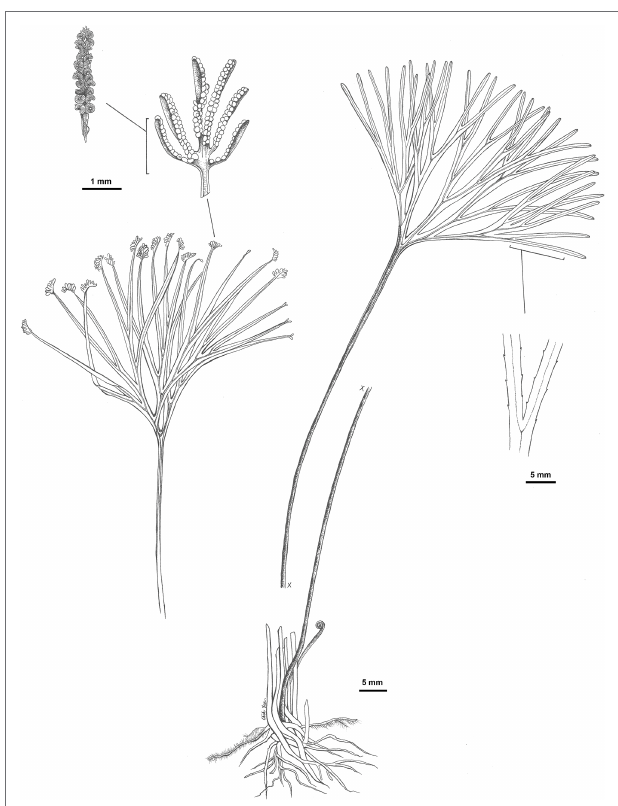
FIGURE 5 | Illustration of Schizaea medusa L.-Y. Kuo, B.-F. Ke, F.-W. Li, and Rouhan, sp. nov., based on the holotype G. Rouhan 1284